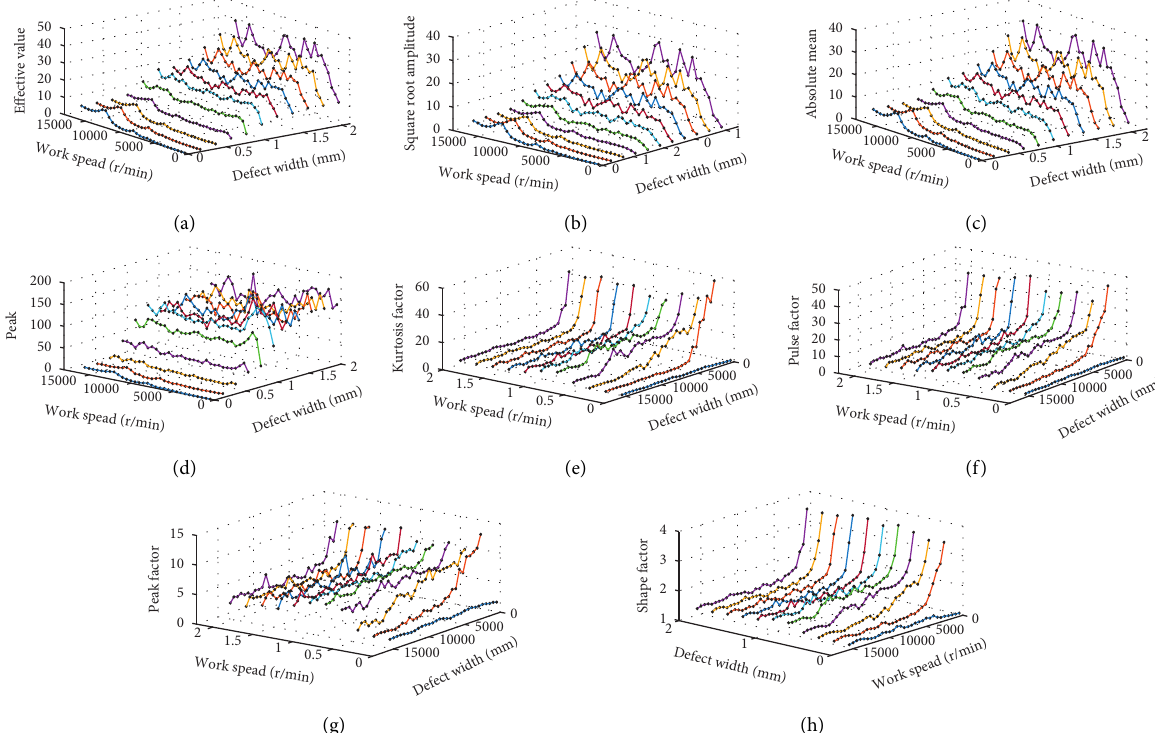
Figure 10: Effect of working speed on characteristic parameters under different defect widths. (a) Effective value. (b) Square root amplitude. (c) Absolute mean value. (d) Peak value. (e) Kurtosis factor. (f) Pulse factor. (g) Peak factor. (h) Shape factor.